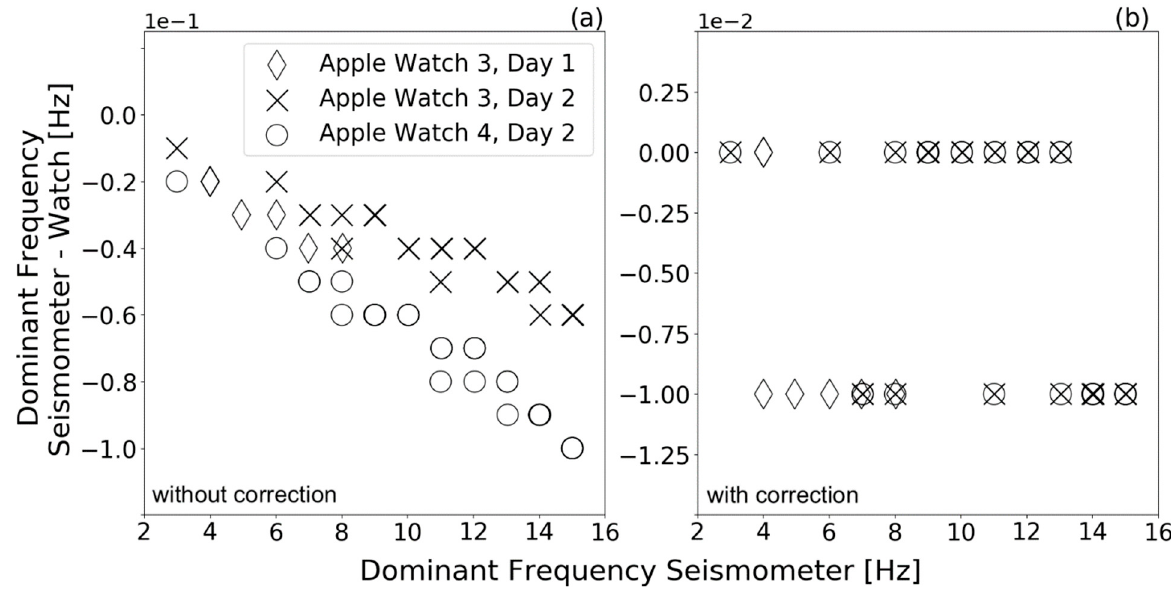
Figure 4. Differences between the dominant frequency measured by the Trillium Compact seismometer and Apple Smartwatches Series 3 and 4 in a shaker table experiment. The experiment was conducted on two different days with the Apple watch Series 3. The figure shows the difference in dominant frequency ( a ) using the pre-defined watches’ sample rate and ( b ) using the watches’ actual sample rate (calculated with watch-specific timestamps) for spectral calculations. Data points that have exactly the same value lie on top of each other in the plot. To show the effect of amplitude on these frequency differences, some measurements were repeated by keeping the shaking table frequency constant and varying the shaking table amplitude.